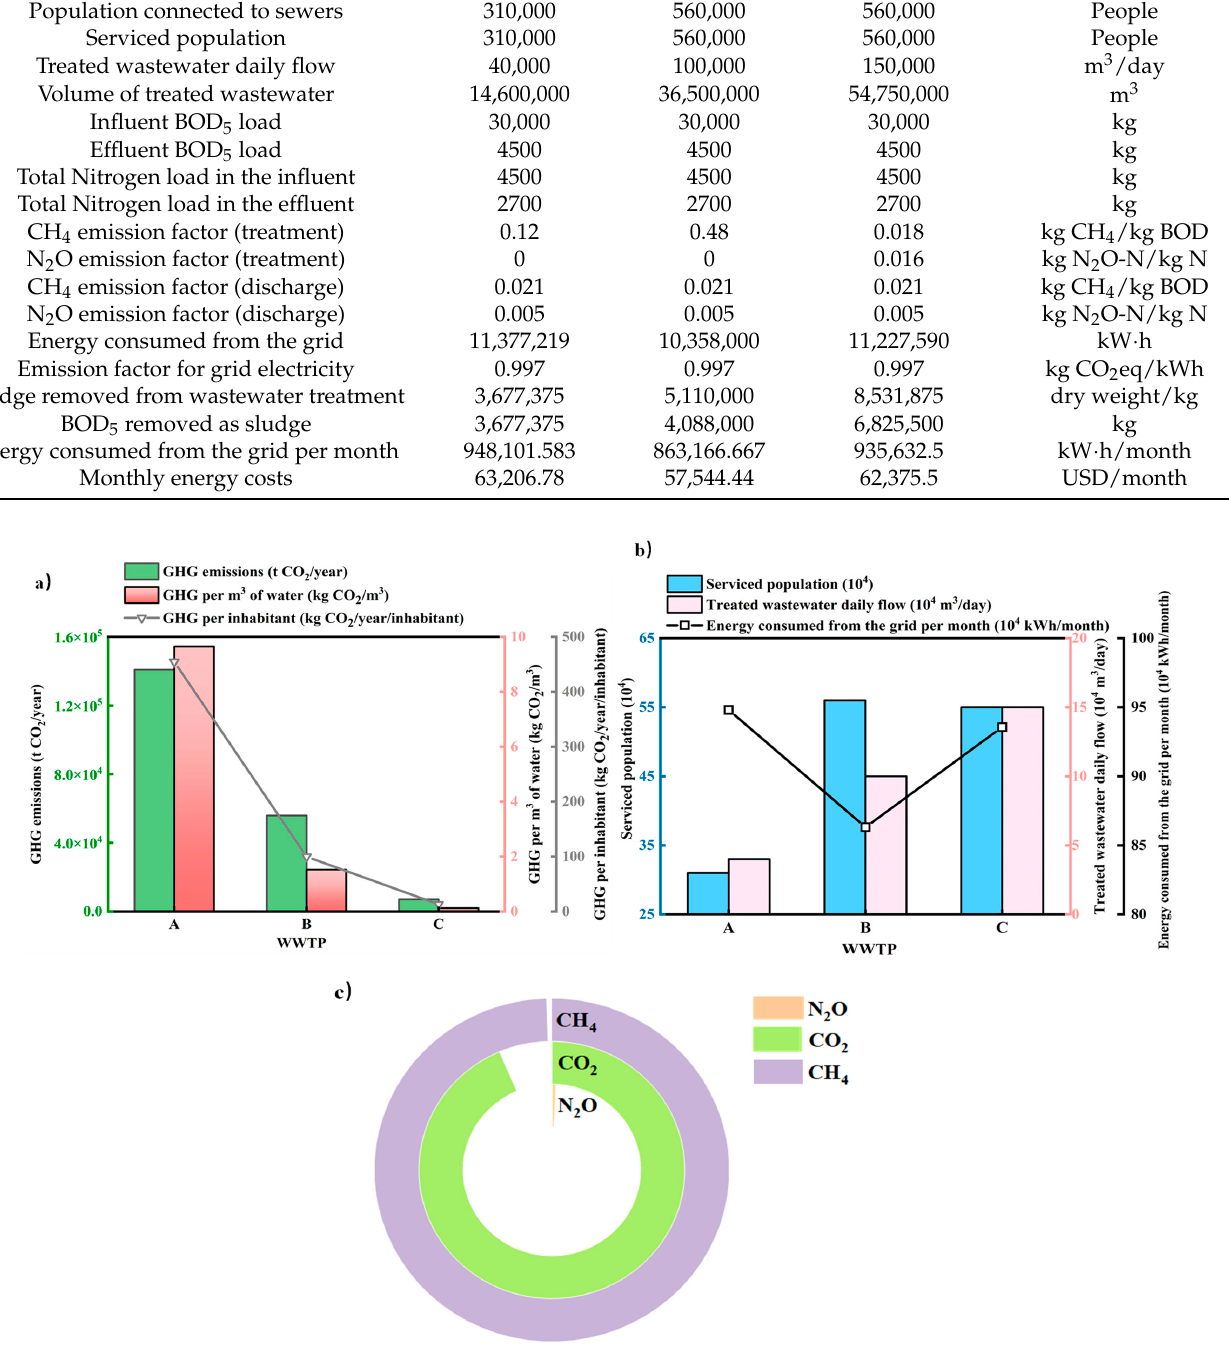
Figure 4. Relationship between service population, treated water quantity, and energy consumption in three Kunming WWTPs ( a ), relationship between GHG emission and treatment water in three Kunming WWTPs ( b ), and GHG emission composition and proportion of A WWTP ( c ). Table 4. Digital data to the rapid assessment stage of the ECAM tool—WWTP in Kunming.